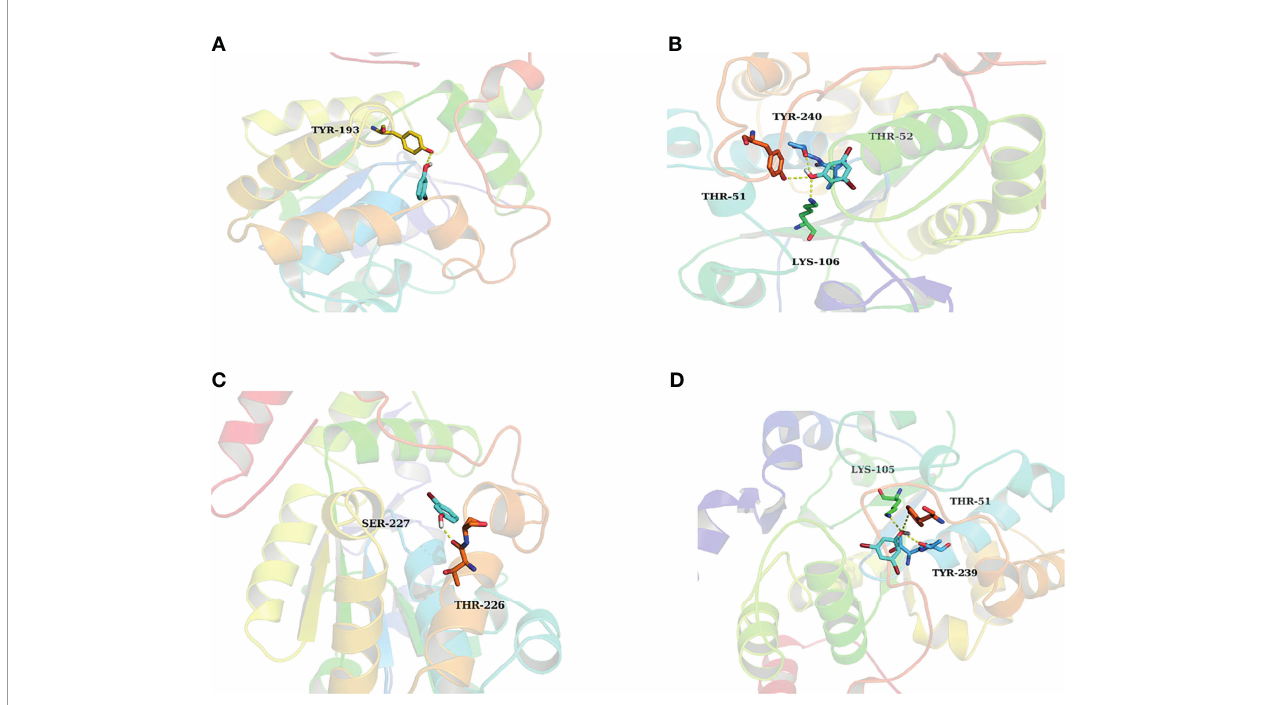
FIGURE 4 | The activity cavity of between 3-BP, 3,5-DBP and SULT1A3, SULT1E1. 3-BP formed 1 hydrogen bond with SULT1A3 (A) and SULT1E1 (C) , respectively. 3,5-DBP formed 3 hydrogen bonds with SULT1A3 (B) and SULT1E1 (D) ,